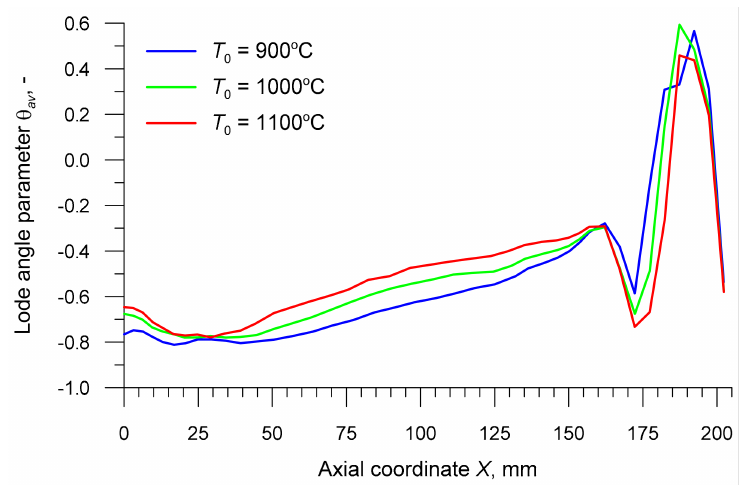
Figure 13. Lode angle parameter in the axial zone of the specimen versus billet temperature T 0 .